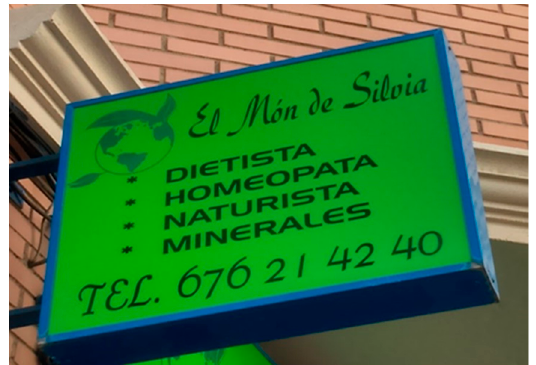
Figure 30. Almazora: Bilingual sign on a health food shop.